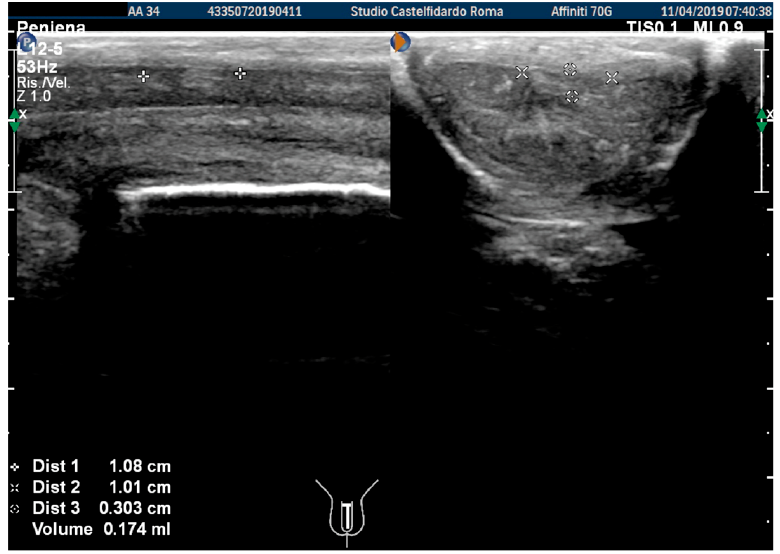
Figure 1. Ultrasonography of the penis before therapy (longitudinal and axial views).